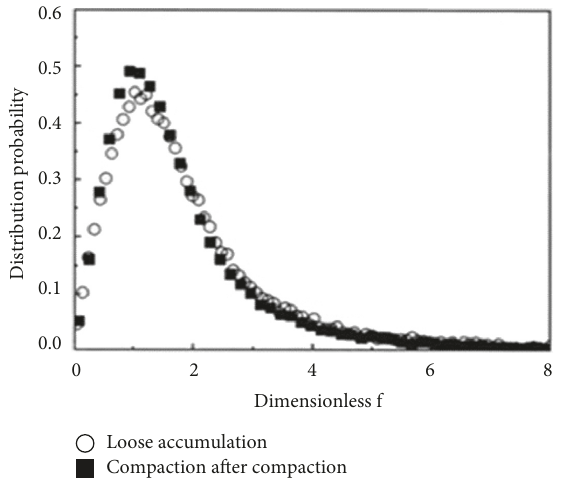
Figure 4: Distribution diagram of contact force between particles in